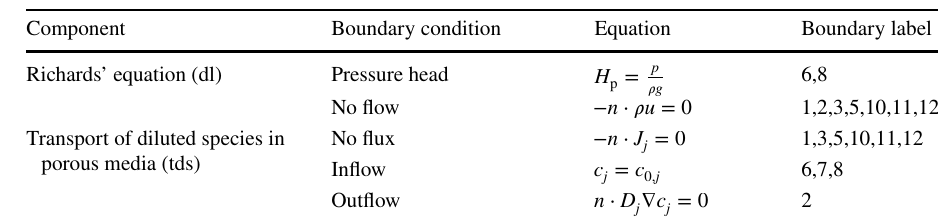
Table 2 Setting of boundary conditions